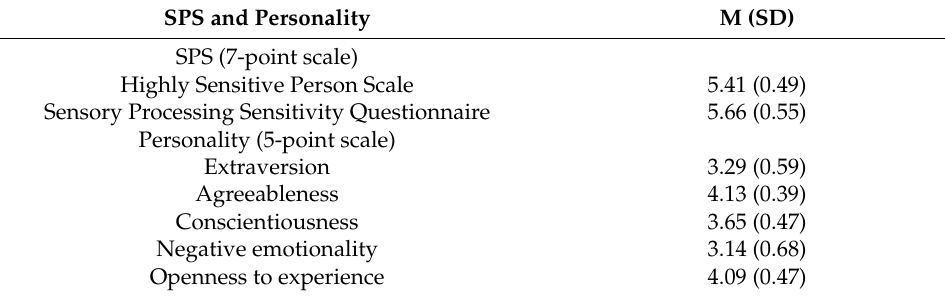
Table 1. Characteristics of the sample: SPS and Big 5 personality.